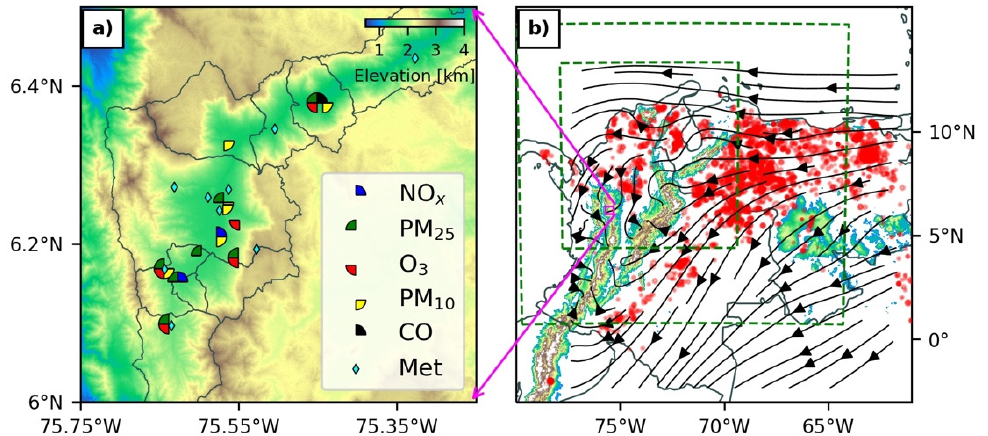
Figure 1. Study area. ( a ) Color shades show terrain elevation, pie charts show the used air quality stations, cyan diamonds show the meteorological stations, and the gray line shows the AMVA municipal limits. ( b ) Location of AMVA in the tropical Andes, active fires (“hotspots”) detected between 16 March and 18 April 2020 from MODIS Collection 6 at the 99% confidence level (red circles whose diameter indicates fire radiative power), and ERA5 850 hPa wind streamlines in black. Dotted rectangles show the modeling domains. Terrain elevations >1 km are shown in color shades with the color bar of panel ( a ).